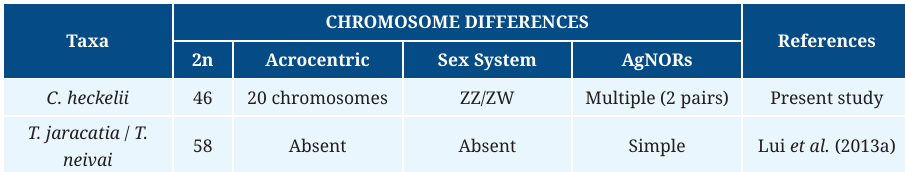
TABLE 1 | Chromosomal differences between Centromochlus heckelii and species of Tatia